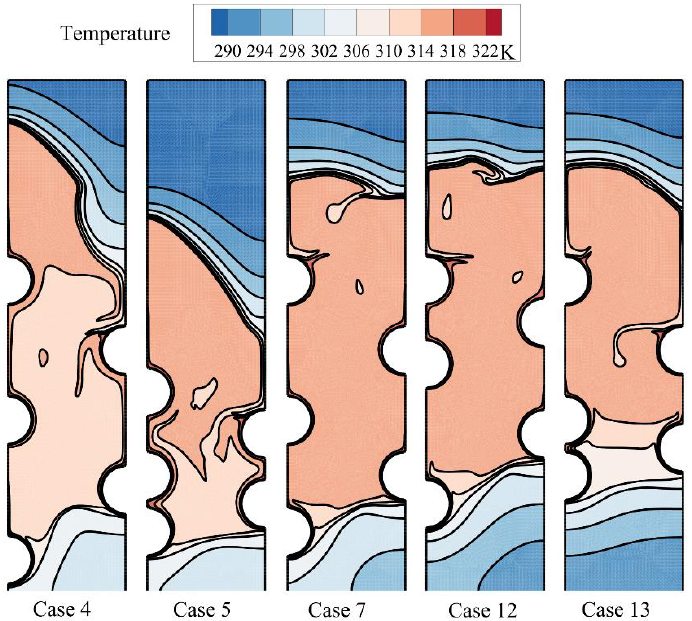
Figure 9. The isotherms for five different arrangements of the tubes after two hours of charging.